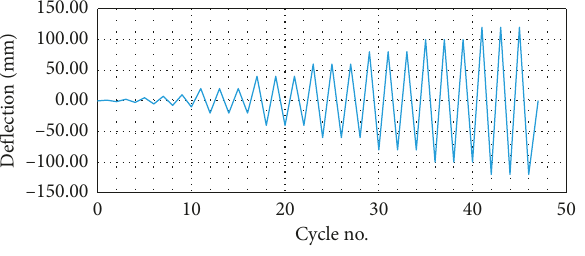
Figure 5: Quasi-static lateral loading